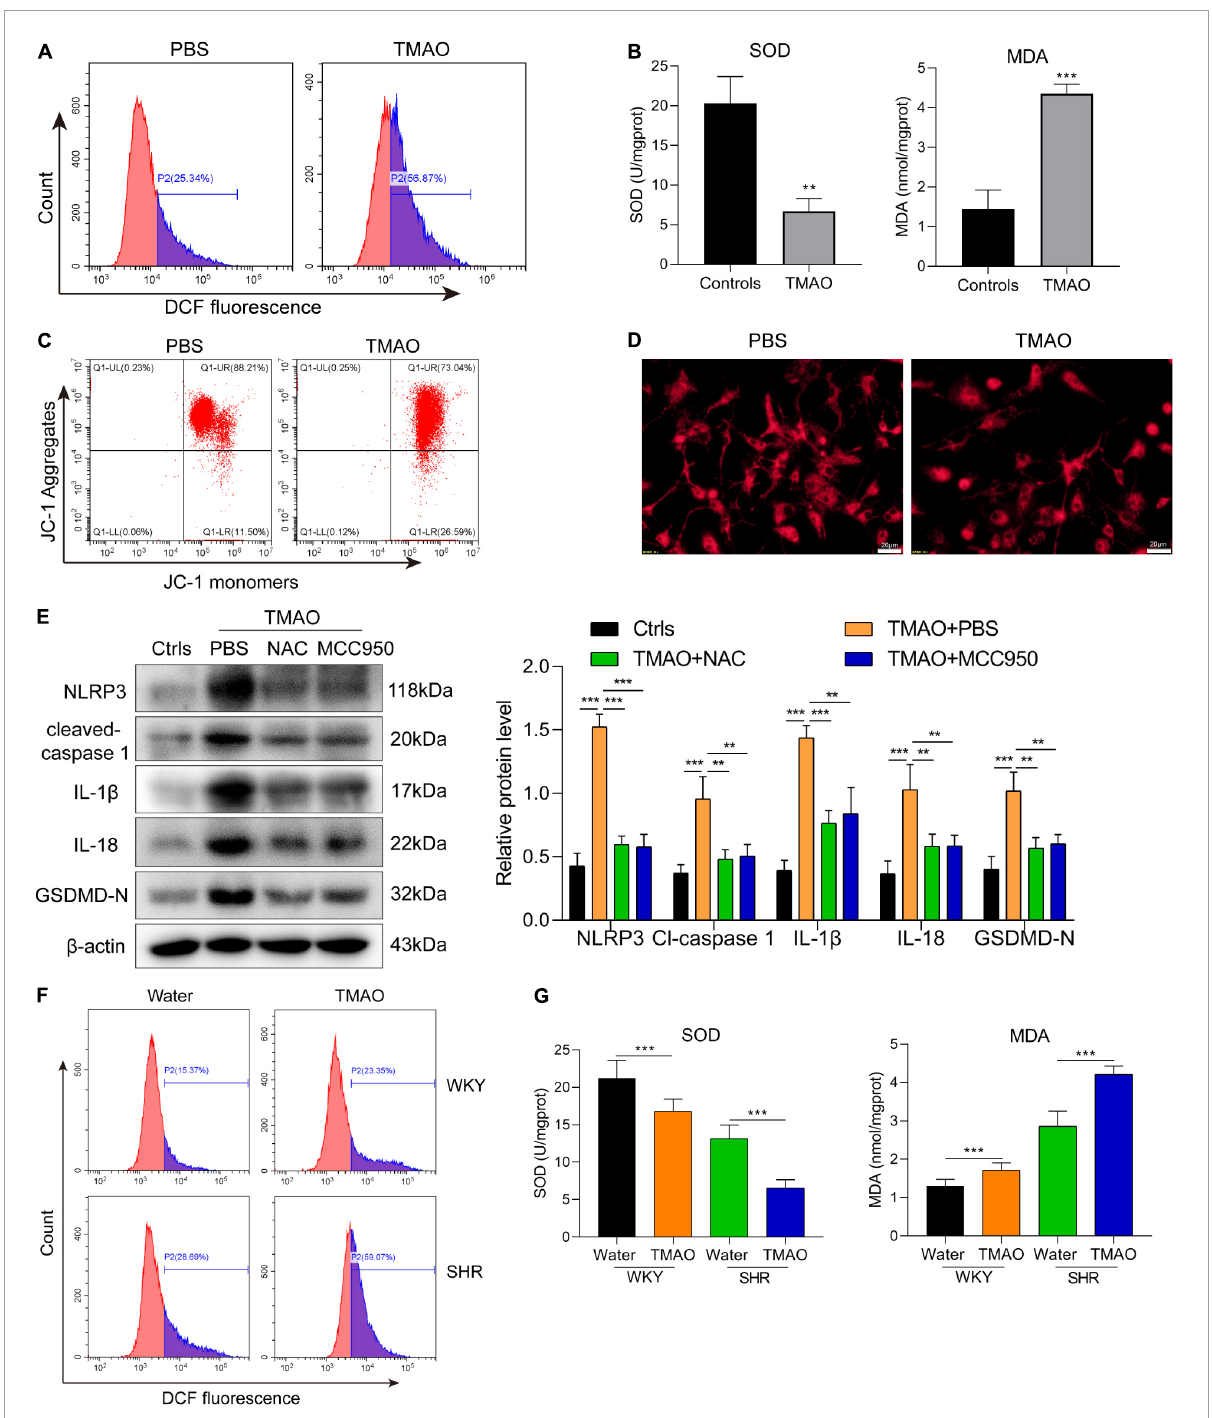
FIGURE4 TMAO activated ROS/NLRP3 pathway to induce pyroptosis of oligodendrocytes. (A) The ROS level in oligodendrocyte was evaluated via DCFH-DA fluorescent probe. (B) The levels of SOD and MDA in oligodendrocyte were detected by ELISA assay. (C) Flow cytometry based on JC-1 staining was used to detect the change of mitochondrial membrane potential. (D) Mito-tracker red probe was used to evaluate the mitochondrial damage of oligodendrocytes in vitro . Scale bar = 20 µ m. (E) The expressions of NLRP3, IL-1 β , IL-18, cleaved-caspase 1 and GADMD-N terminal in cells were detected via western blot. (F) The ROS level in cerebrum was evaluated via DCFH-DA fluorescent probe. (G) The levels of SOD and MDA were detected by ELISA assay. The data were expressed as mean ± SD of three independent experiments. ** P < 0.01, *** P <